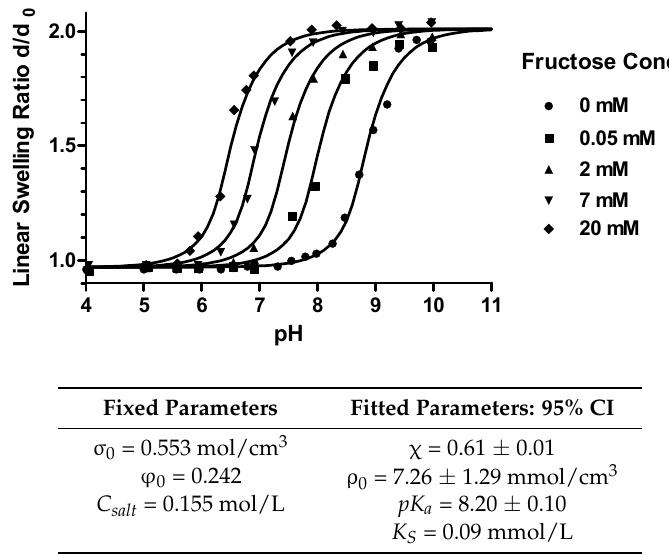
Figure 2. Fit of Flory–Huggins–Donnan–Langmuir (FRDL) model Equations (3)–(5) to fructose data in Figure 1a.